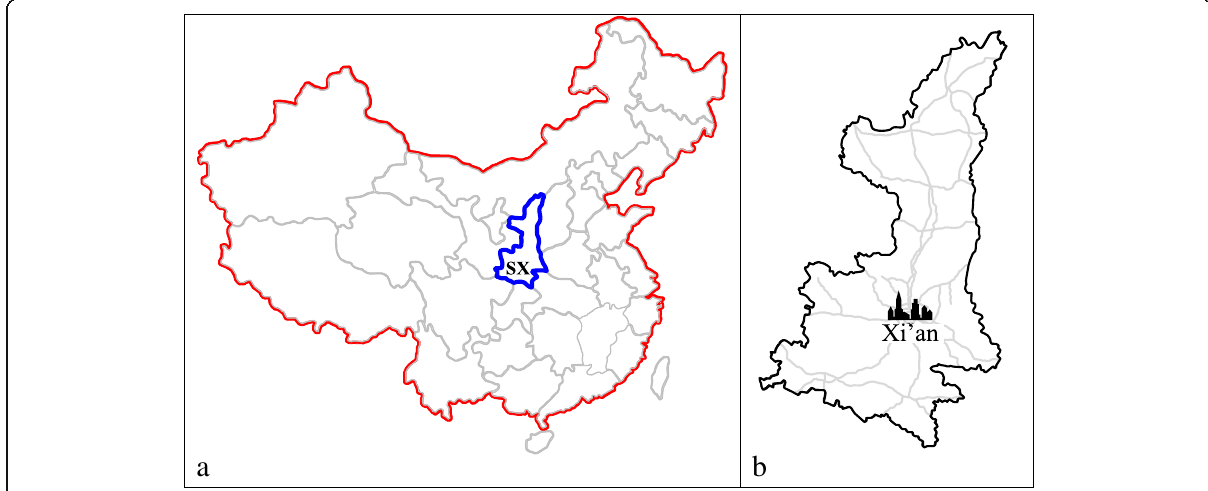
Fig. 1 Location of the questionnaire survey. a Shaanxi (SX) Province in China; b Xi ’ an in the center of the Guanzhong